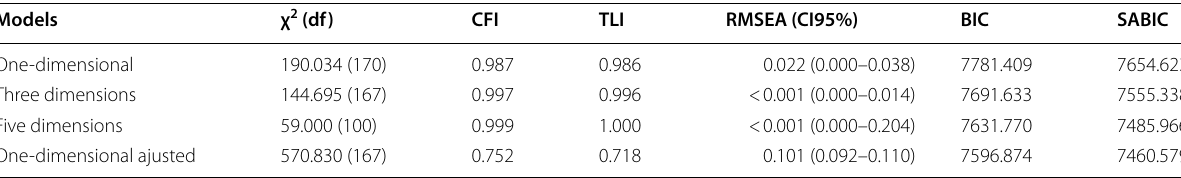
Table 4 Factor adjustment and retention indexes for PFDI-20 models